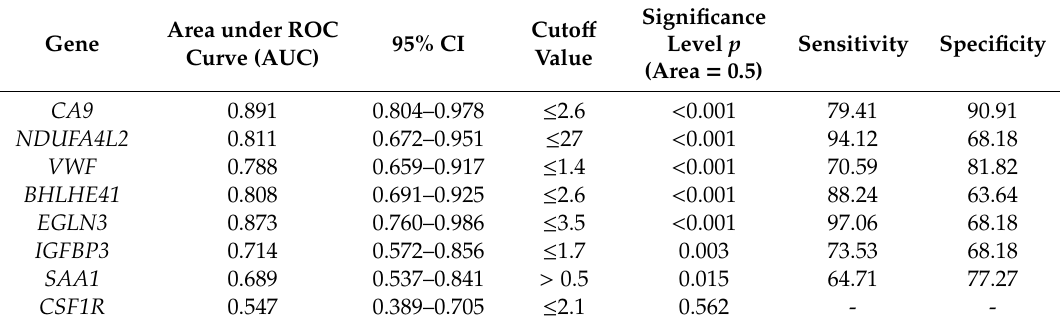
Table 2. The relationship of gene expression with the development of metastases—ROC